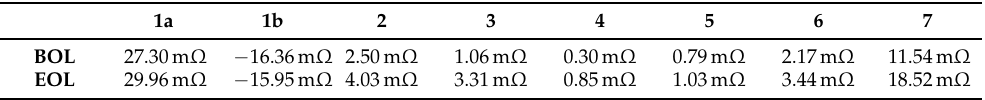
Figure A2. Number of peaks of the distribution of gains determined with gDRT as function of the regularization parameter. Table A1. Distribution of gains for the different processes obtained by LM.